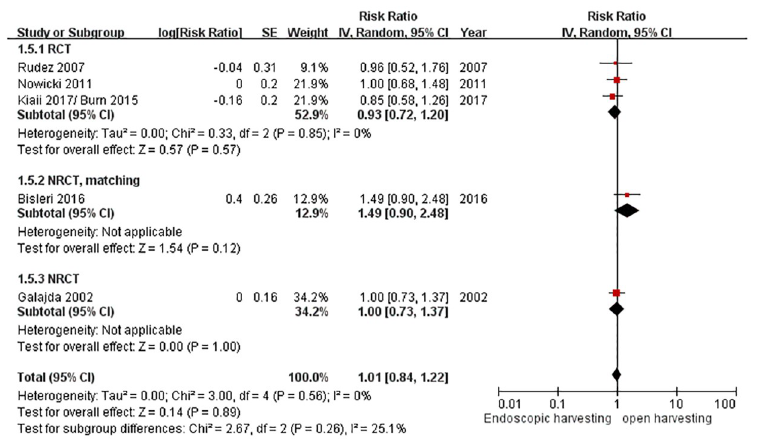
Fig 7. Forest plot for the long-term survival